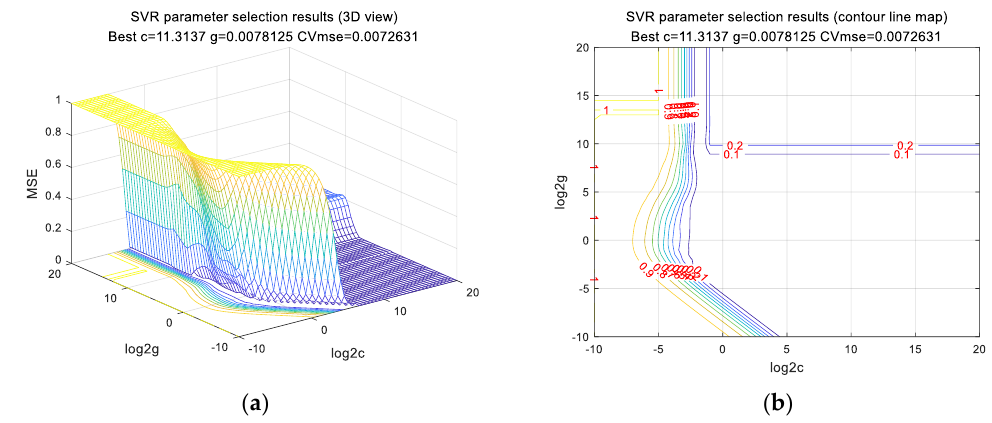
Figure 3. Diagram of parameter optimization process. ( a ) 3D view, ( b ) contour map.